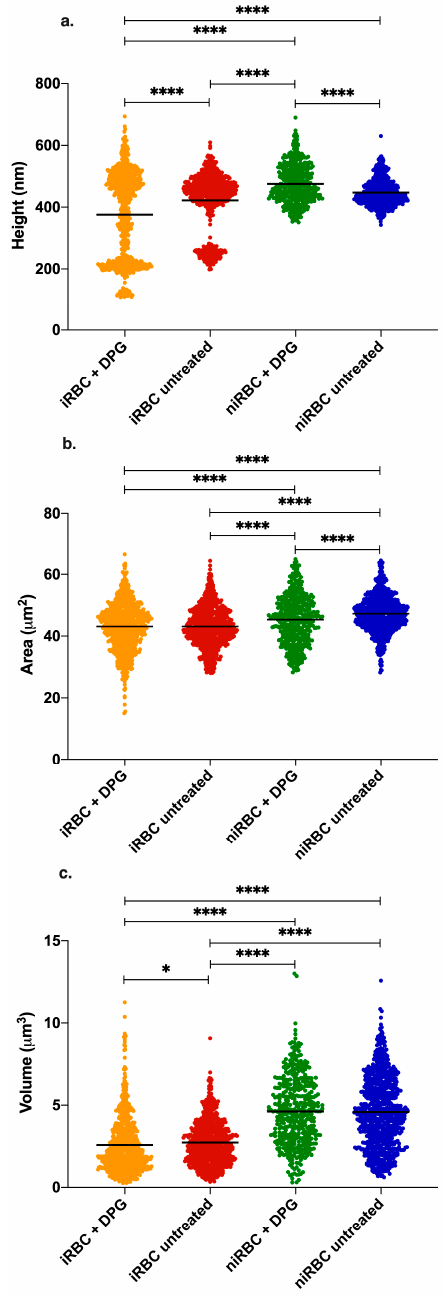
Figure 4. AFM imaging results of infected cultures and uninfected RBCs after 30 h incubation with or without 2,3-DPG 8 mM. ( a ) RBC height; ( b ) RBC area; ( c ) RBC volume. Parasites in infected samples were at the trophozoite stage. Each panel includes data from three independent experiments. iRBC + DPG—cultures with infected RBCs treated with 2,3-DPG (height n = 765; area n = 771; volume n = 766); iRBC untreated—cultures with infected RBCs untreated (height n = 741; area n = 734, volume n = 741); niRBC + DPG—noninfected RBCs treated with 2,3-DPG (height n = 432; area n = 429, volume n = 432); niRBC untreated—untreated noninfected RBCs (height n = 718; area n = 783; volume n = 812) (* p = 0.0444 and **** p < 0.0001; p -values were generated by Dunn’s multiple comparisons test). All descriptive statistics and p -values are presented in Tables S3–S5. The infection by P. falciparum had consistently more impact on the cell biomechanical properties and morphology than the presence of 2,3-DPG amongst all the AFM experiments, iRBC being more rigid and smaller than